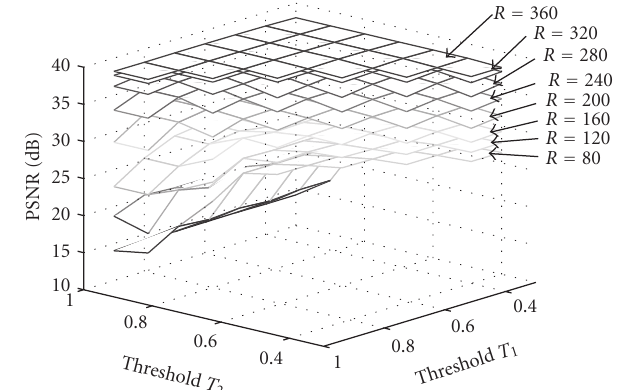
Figure 6: Setting of PRED thresholds, R represents the outlink rate in